Question: According to the figure, is the described quantity increasing or decreasing?
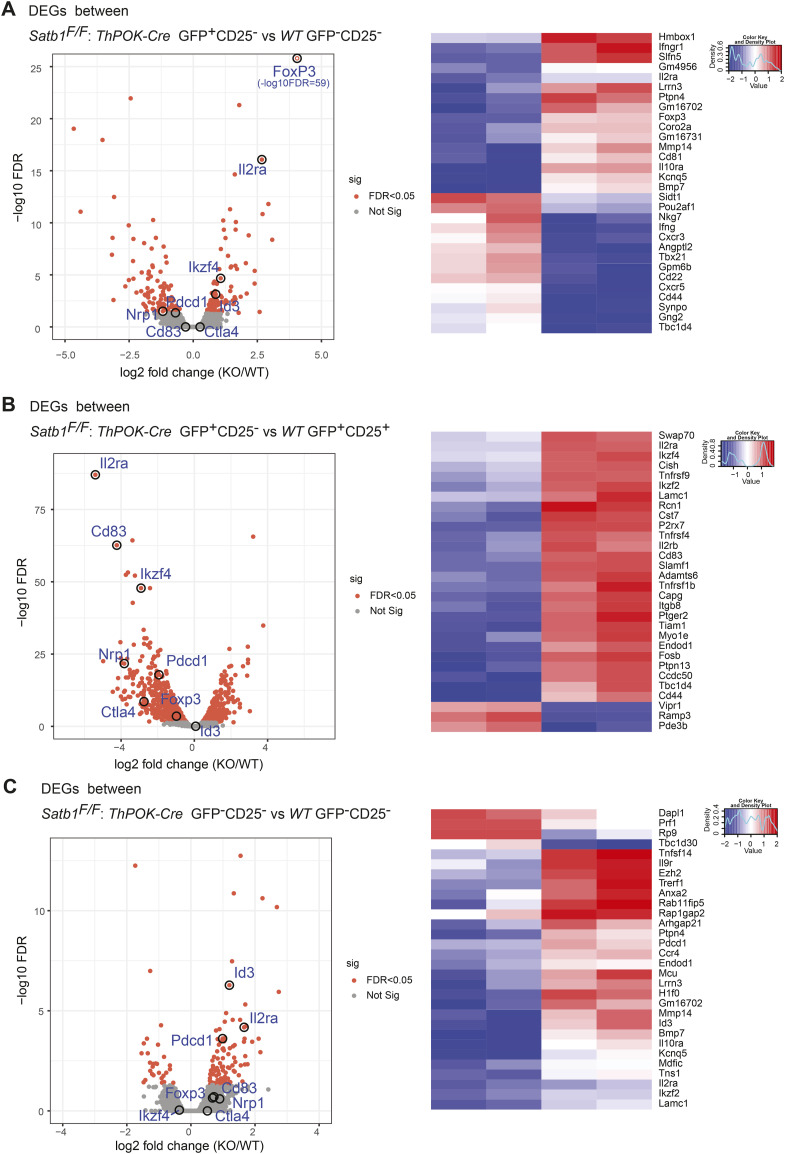
Answer: increasing